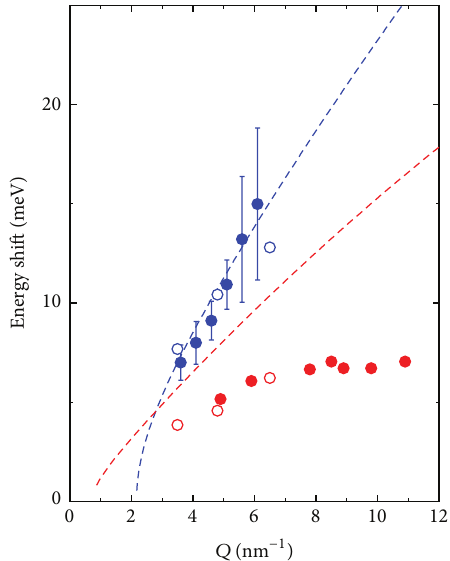
Figure 2: The dispersion curves of the low frequency (red dots) and high frequency (blue dots) modes in the spectrum of D 2 O are reported as measured by INS in [24] and [25], respectively. The boundaries of the (𝑄, 𝐸) range accessible by the two INS measure- ments are represented by the dashed parabolas of corresponding colors.Openredandbluedotsrepresent,respectively,thedispersion of the low and the high frequency modes, as determined by the MD computation of Rahman and Stillinger